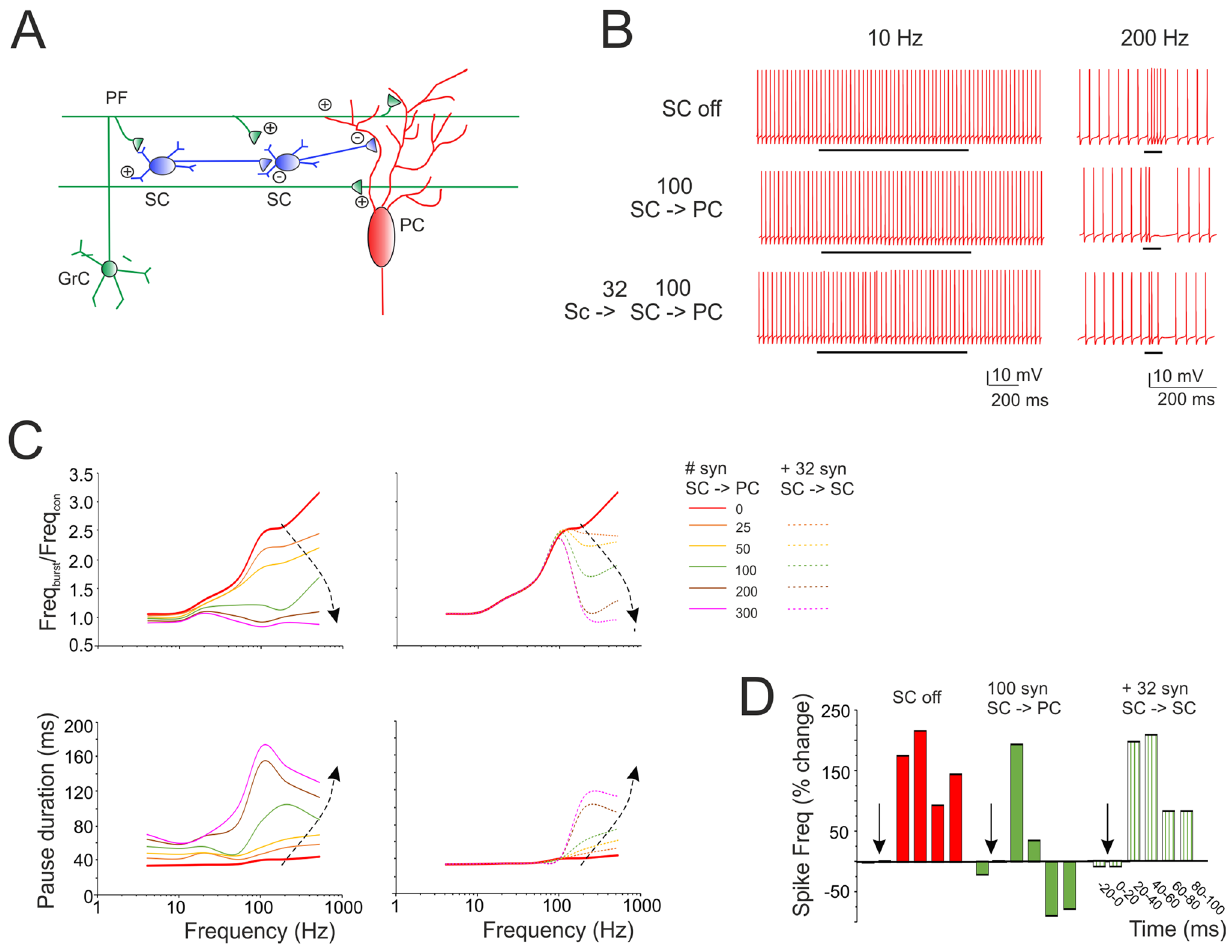
Figure 8. Prediction of SC filtering of PC responses along the PFs. (A) Schematics of the afferent connections to a PC activated by PF stimulation. Granule cell (GrC); parallel fiber (PF); stellate cell (SC); Purkinje cell (PC). The figure highlights the interactions of elements in the cerebellar molecular layer and the location of afferent PC synapses. (B) The traces show simulated PC response to 10 pulses at different frequencies (10, 200 and 500 Hz) delivered to 100 PFs in which (i) SCs were not activated (SC off), (ii) 100 SC synapses were activated (SC – > PC) and (iii) 100 SC synapses received inhibition from 32 SC synapses (SC – > SC – > PC). Black bar indicates the stimulus duration. (C) Input/output PC burst frequency gain (top) and pause length (bottom). Different curves are obtained using PF trains at different frequency (10 pulses @ 4 Hz, 10 Hz, 20 Hz, 50 Hz, 100 Hz, 200 Hz, 500 Hz) and an increasing number of inhibitory synapses. Dotted traces also include the case of SC-SC inhibition. Note that PC burst and pause showed an almost opposite modulation by SCs. (D) The histogram shows the regulation of PC firing frequency when SCs are off, on and reciprocally inhibited. Note that reciprocal SC inhibition can abolish the effect of SCs on